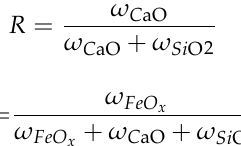
a Exp y = x Taskinen Sugimoto Richardson Figure 2. Comparison of ZnO mass action concentration calculations with activity measurements. It can be seen from Figure 2 that the calculated value of ZnO mass action concentra- tion is in good agreement with the measured value obtained from previous experimental studies, with an average deviation of 18.86%. The calculated mass action concentration is in better agreement with Taskinen’s measurement results, and there are some deviations